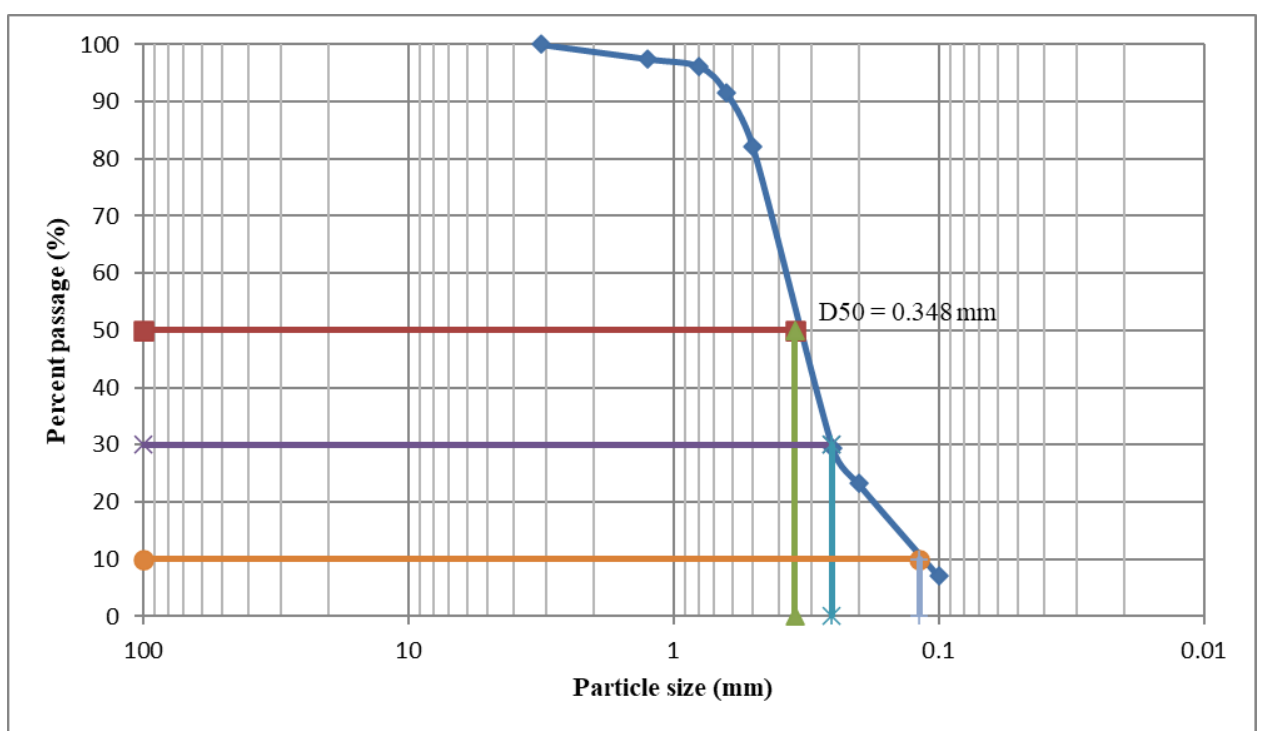
Figure 3. Pore topography for the two polyurethane sponges that were used as sacrificial templates obtained with confocal microscopy: ( a ) green (G) and ( b ) blue (B).